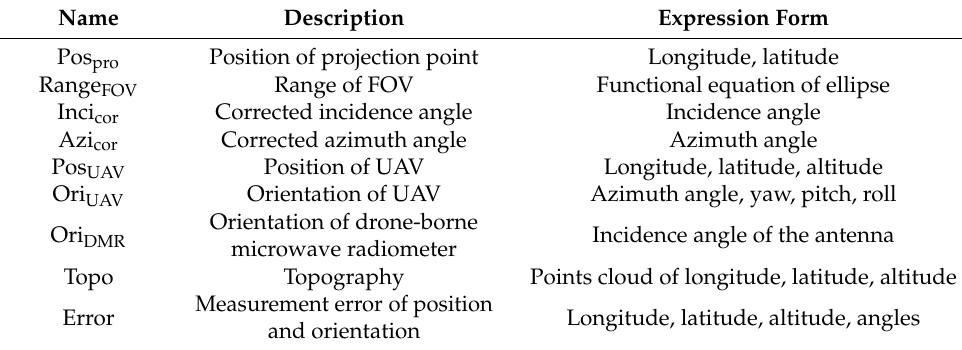
Table 4. The descriptions and expression forms of the projection